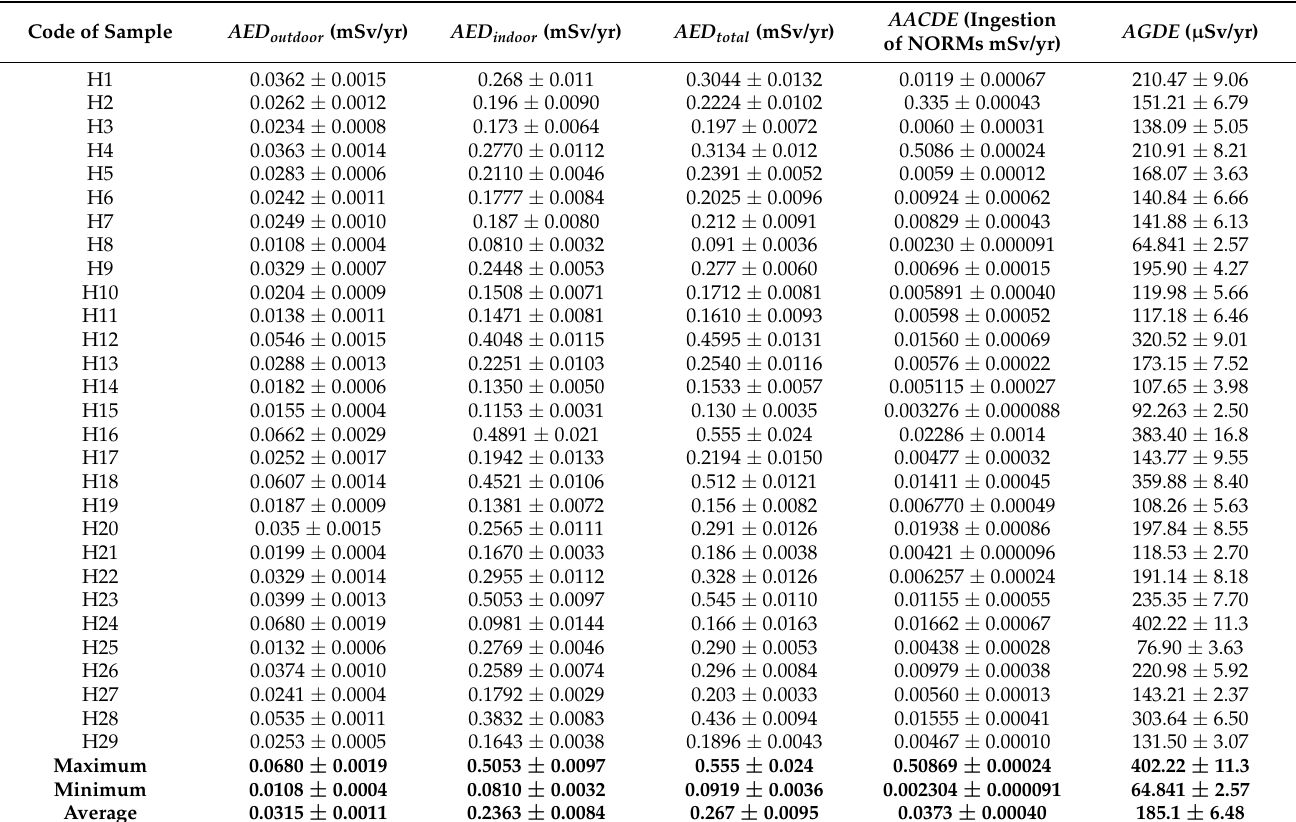
Table 4. The outdoor ( AED outdoor ) and indoor ( AED indoor ) annual effective doses and total annual effective doses ( AED tot ) for different medicinal plant